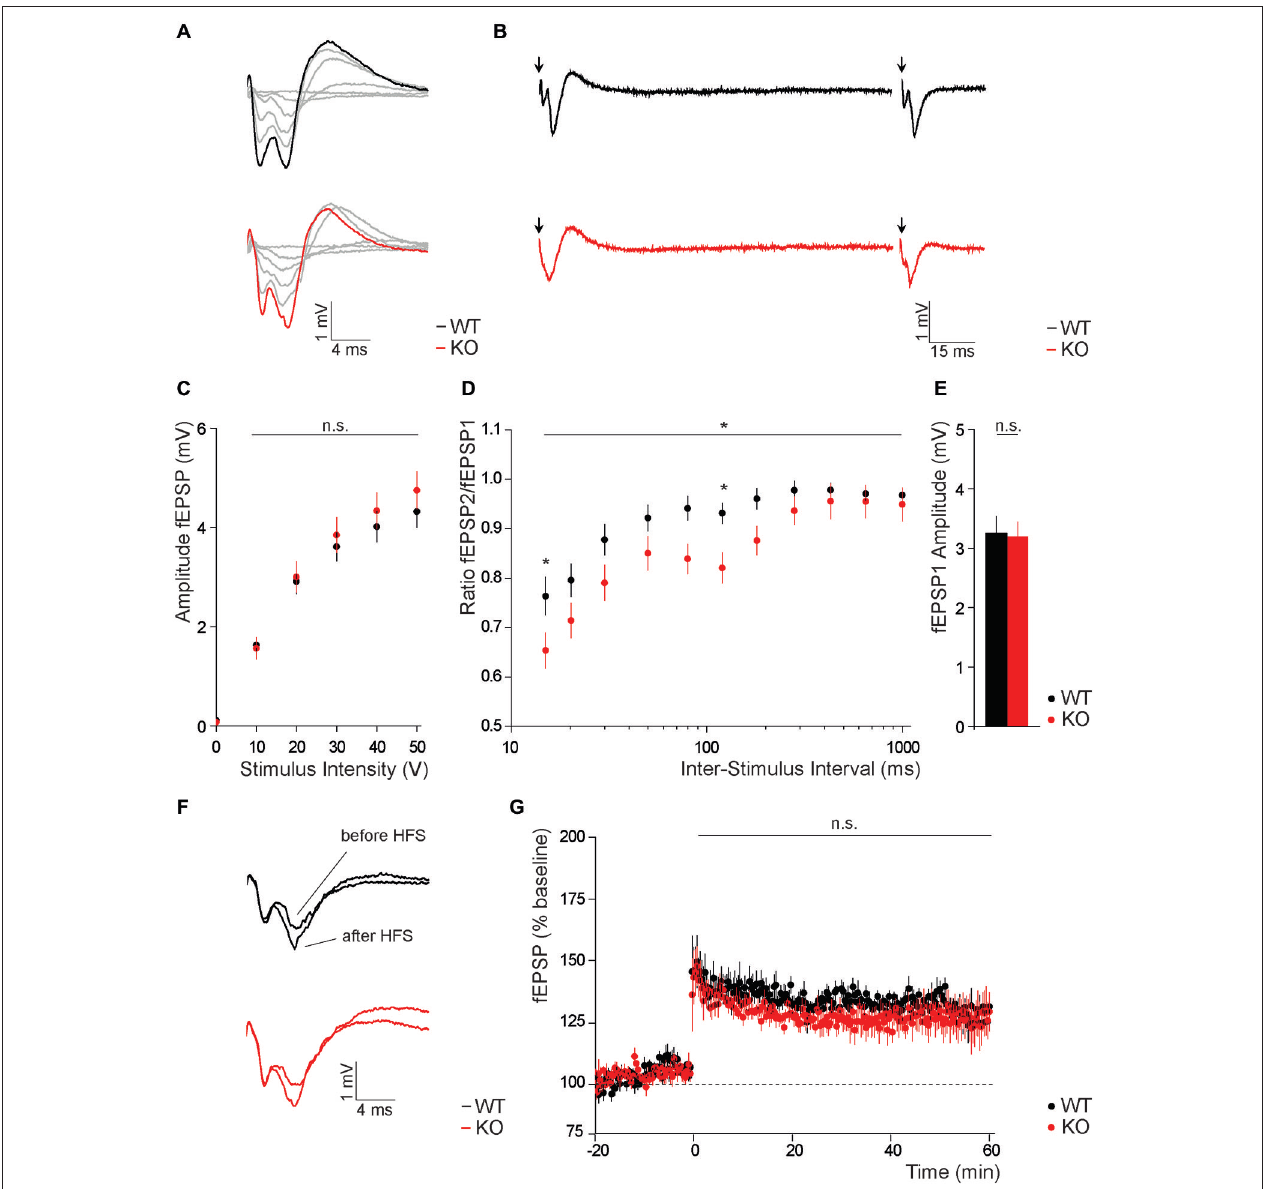
This was most obvious at an inter-stimulus interval of 15 and 120 ms ( p = 0.015; n = 40/50). (E) No difference was observed for the mean first fEPSP amplitude upon half-maximal stimulation ( p > 0.05; n = 40/50). (F) Exemplary traces of fEPSPs recorded in cortical layers 2/3 of WT and KO slices before and after columnar high frequency stimulation. (G) LTP recordings from WT and KO slices did not reveal genotype dependent differences in the potentiation of cortical fEPSP amplitudes after high frequency stimulation. * p <